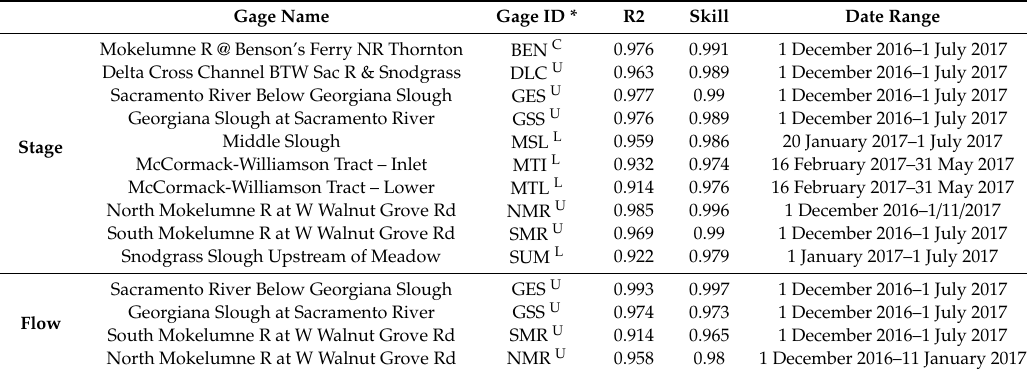
Table 1. Model calibration metrics for the gages shown in Figure